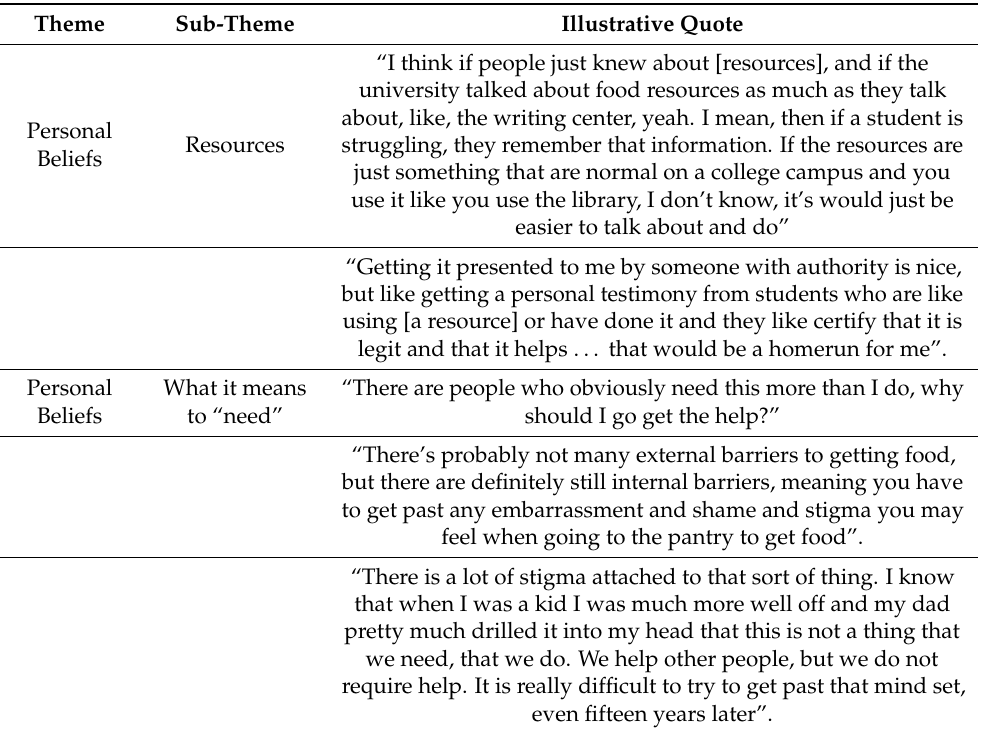
Figure 1. Qualitative results identified influencers of food insecurity status in undergraduate college students. Table 2. Themes, Sub-themes, and Illustrative Quotes for Influencers of Food Insecurity Status in College